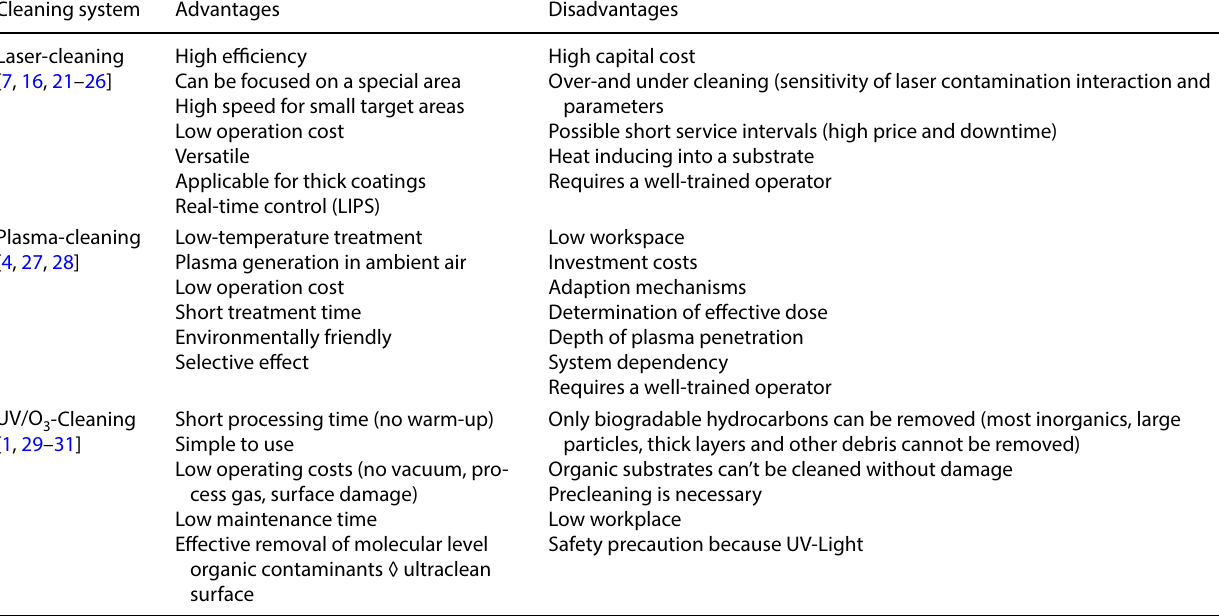
Table 1 Comparison of advantages and disadvantages of the most common used dry-cleaning methods Cleaning